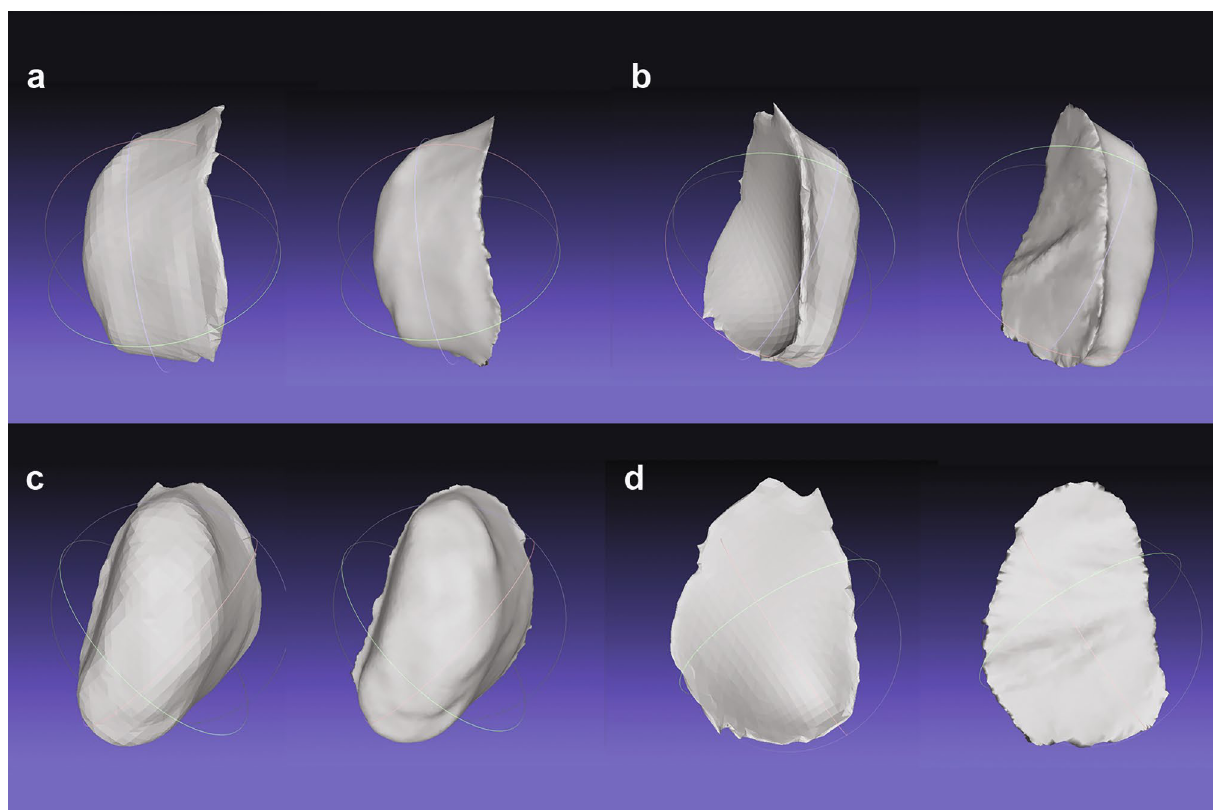
Figure 5. Visual comparison of proprietary and OS/F workflows on Set A (left) and Set B (right). ( a ) Right lateral surface, ( b ) left lateral surface, ( c ) inner surface, ( d ) outer